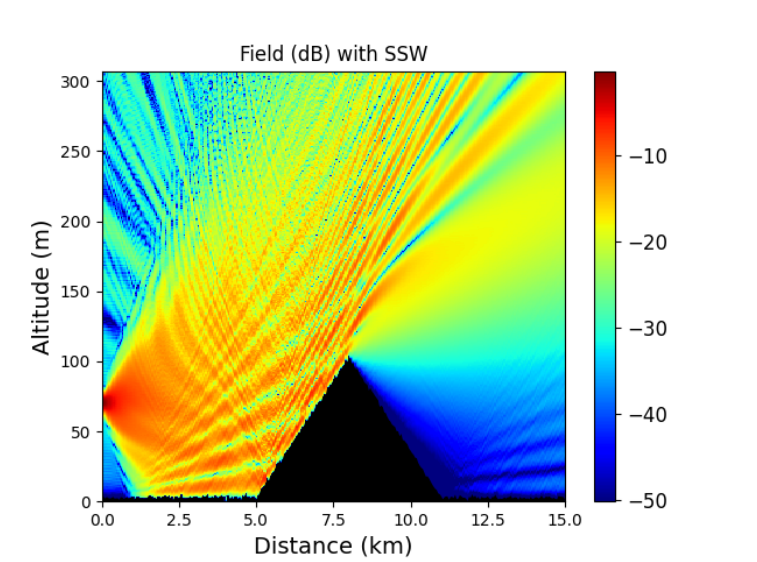
Figure 8. Propagation over a rough terrain obtained with two-way SSW.